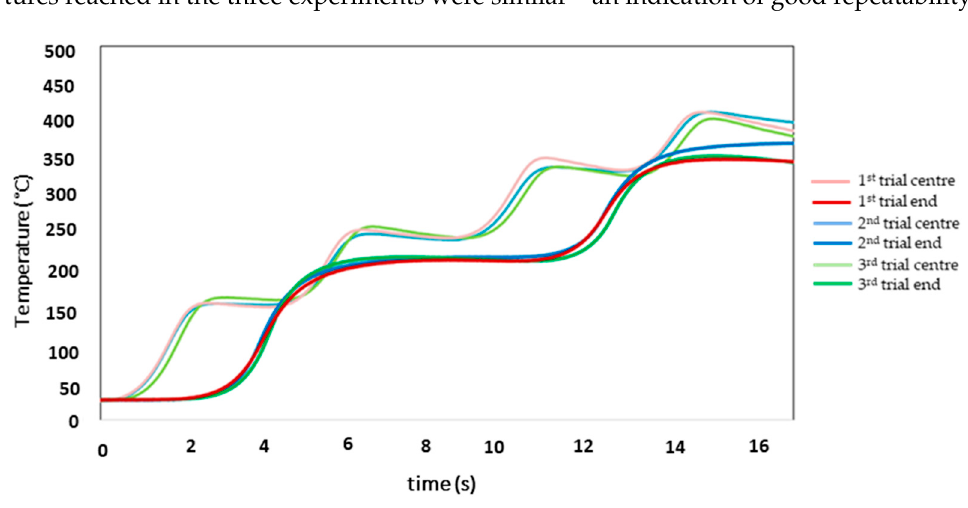
Figure 8. Evolution of temperature as a function of time for the three trials with four scans.